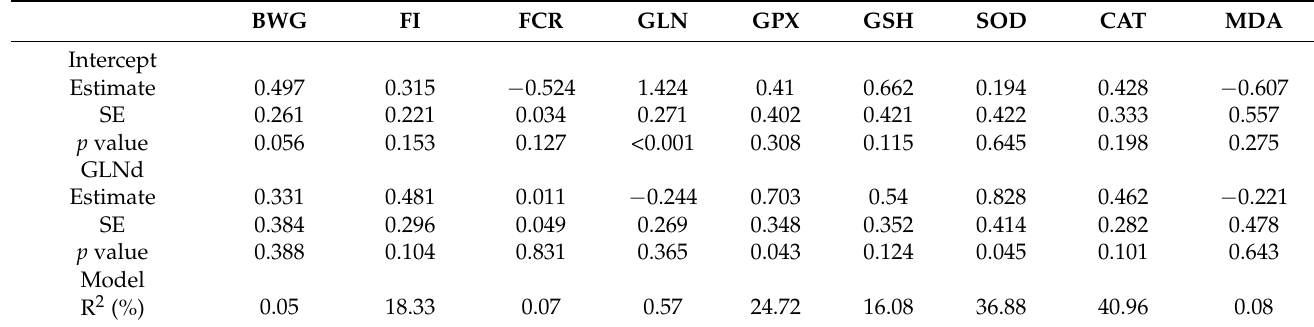
Table 4. Meta-regression models for the influence of the dietary glutamine concentration on the response variables